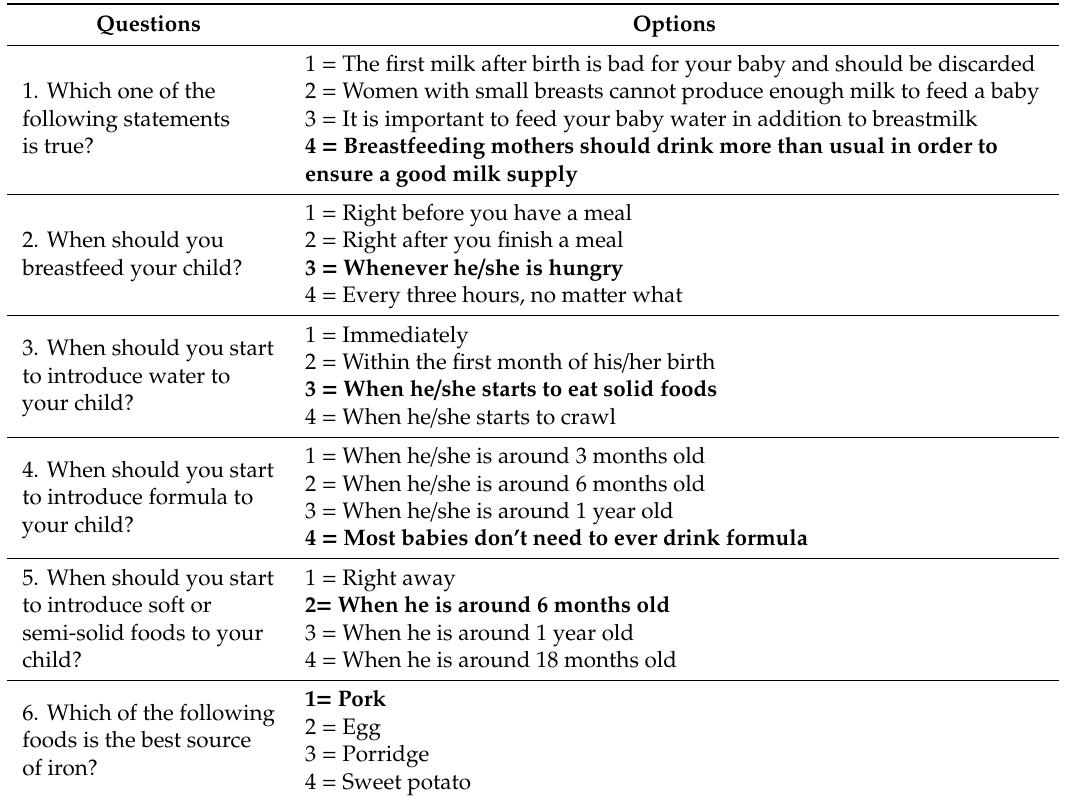
Table A1. Maternal health knowledge